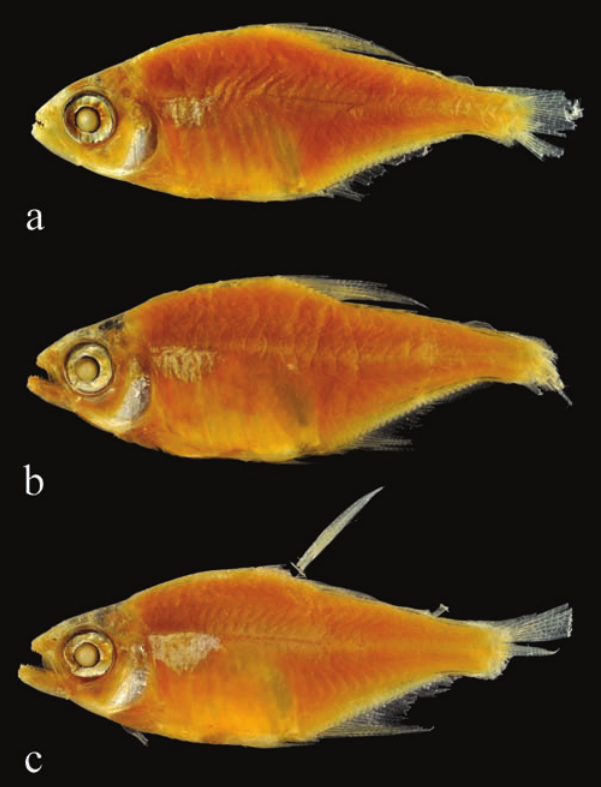
Fig. 4. Hemigrammus lunatus: MCZ 20964, (a) holotype, 26.5 mm SL; (b) paratype, 21.7 mm SL, and (c) paratype, 23.9 mm SL; Brazil, Amazonas State, Codajás, lago Badajós, tributary of rio